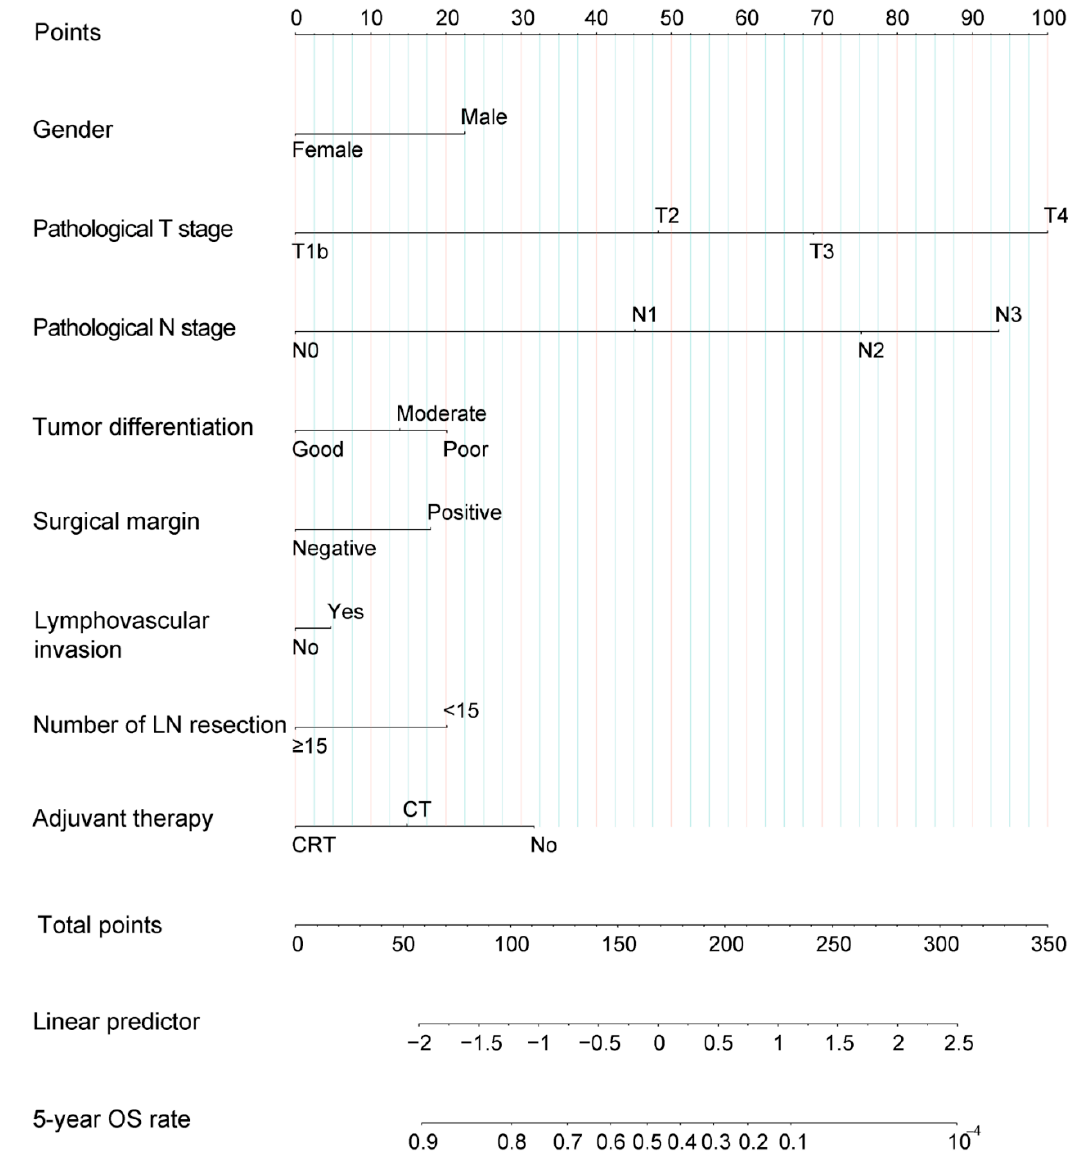
Figure 2. Nomogram for patients with locally advanced esophageal squamous cell carcinoma after esophagectomy. For each variable, an individual’s value is placed on the axis, and a line is drawn upward to determine how many points for each variable. The survival axis is drawn below the total points axis, which is then used to determine 5-year OS rates. LN, lymph node; OS, overall survival.